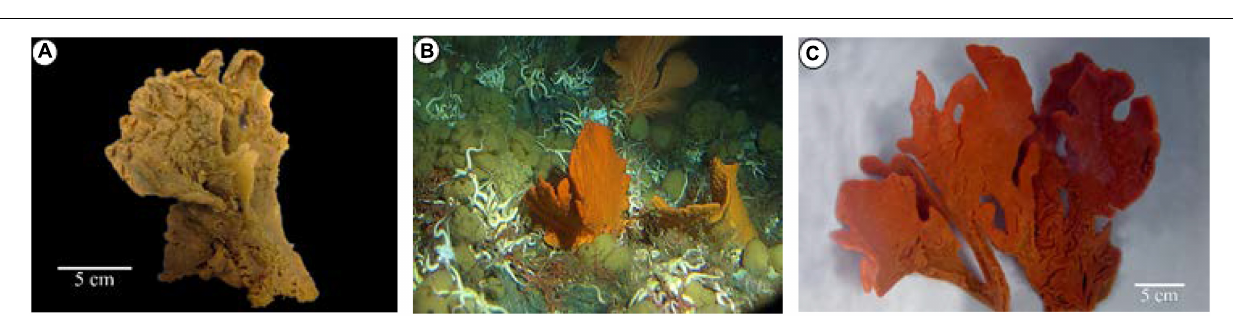
FIGURE 3 | Monanchora cf. pulchra (Lambe, 1894/1895) (Order Poecilosclerida, Family Crambeidae): (A) DDDBS voucher 2011-AK-001 (NIWA 92955), ex situ image showing preserved multi-lamellate form; (B) DDDBS voucher AB13-0177 (NIWA 92958), in situ image showing planar form with inflated surface and brick-red coloration; (C) DDDBS voucher AB13-0177 (NIWA 92958), ex situ